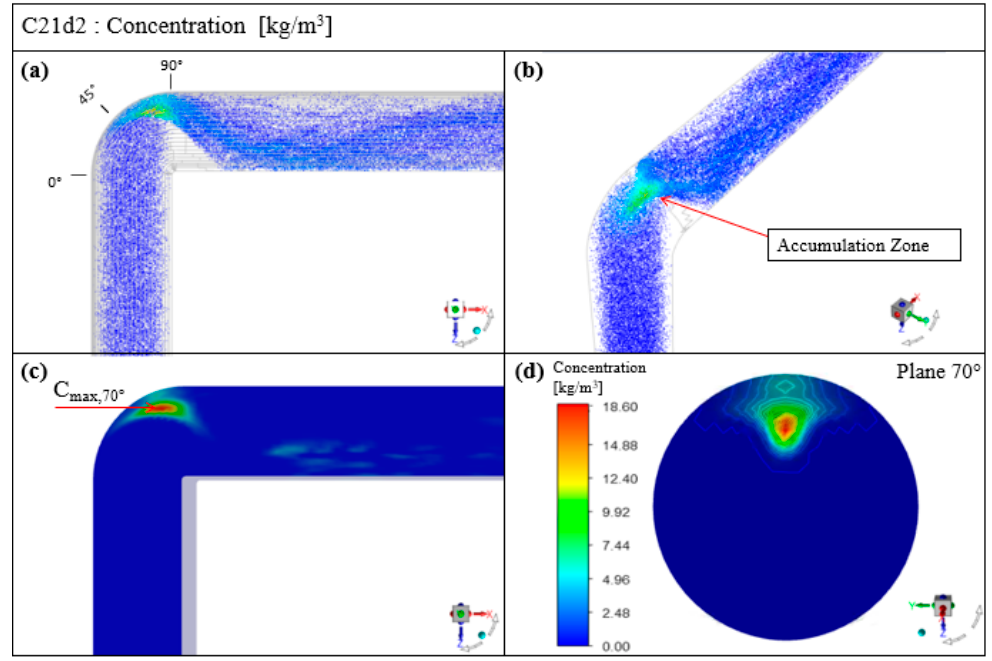
Figure A10. Results of particle concentration. Case C21d2. ( a ) Instant positioning of the X-Z plane particles ( b ) Instant positioning of the particles in 3D view ( c ) Concentration contour in the X-Z plane of the mid-section of the pipe ( d ) Concentration contour in the Z-Y plane of the maximum concentration cross section. Snapshots are taken for a statistically steady flow.